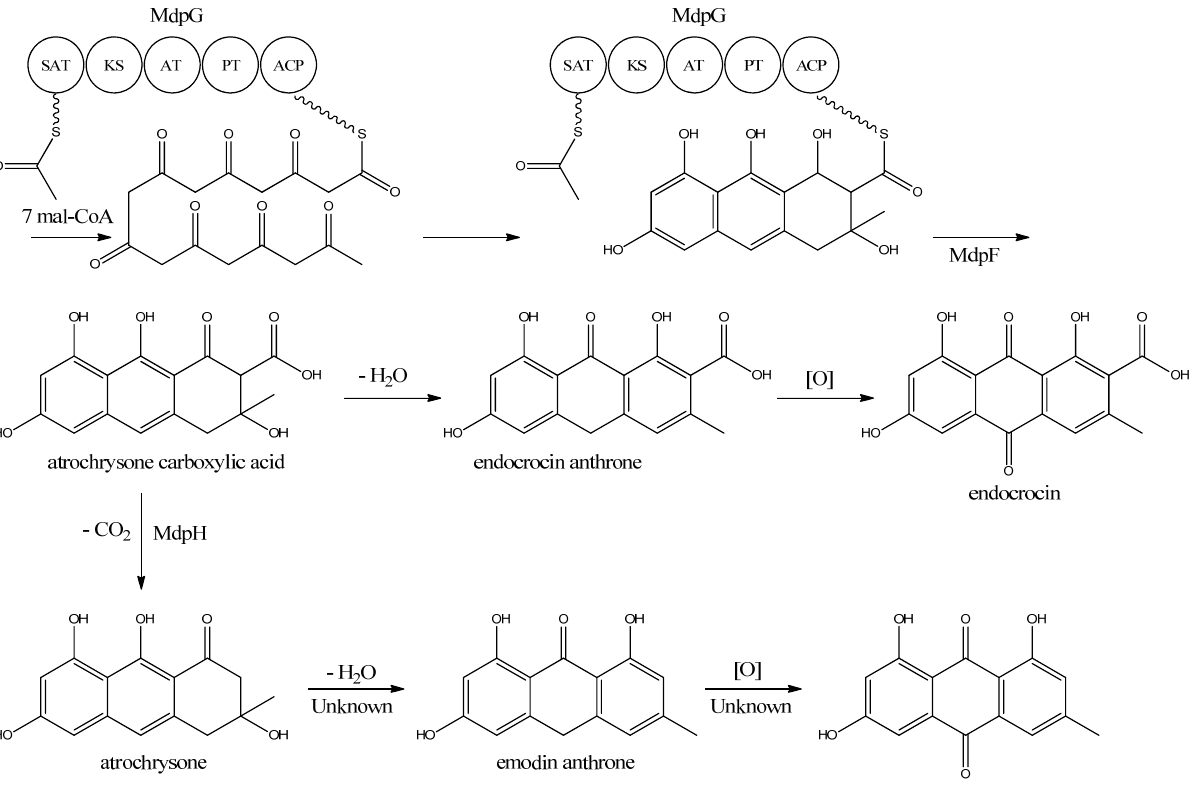
Figure 9. Proposed biosynthesis of emodin. MdpG contains SAT, KS, AT, PT, and ACP